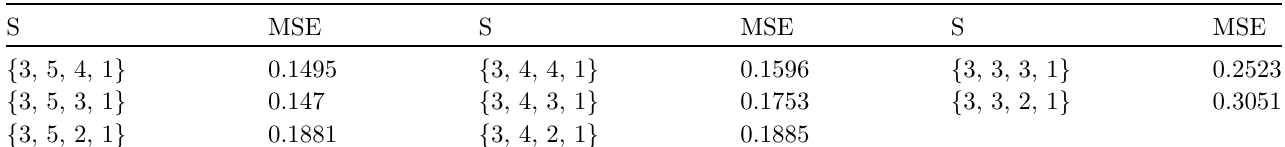
Table 11. ANN Algorithm: GRPROP.